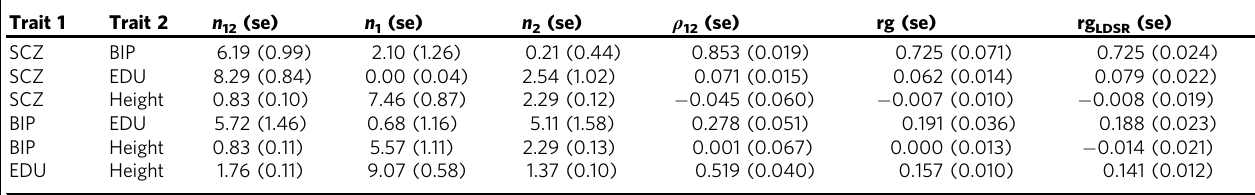
Table 1 The results of cross-trait analysis with the MiXeR model for schizophrenia (SCZ), bipolar disorder (BIP), educational attainment (EDU) and height